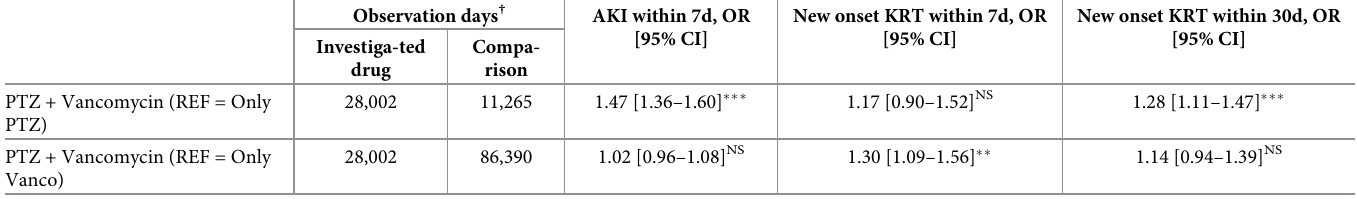
Table 4. Risk of new or worsening AKI and KRT associated with exposure to the PTZ-vancomycin combination compared to PTZ or vancomycin individually